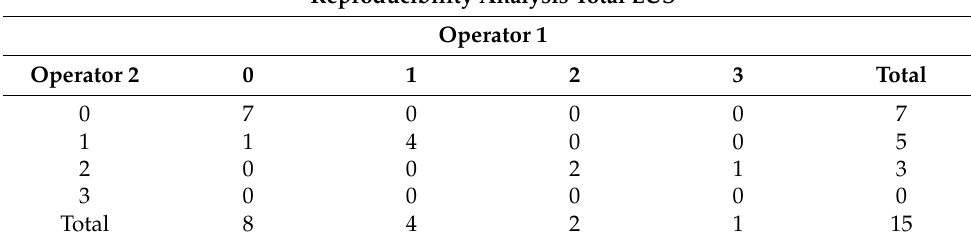
Table 6. Confusion matrix verifying inter-rater agreement. From the top, total LUS rated by operator 1 and